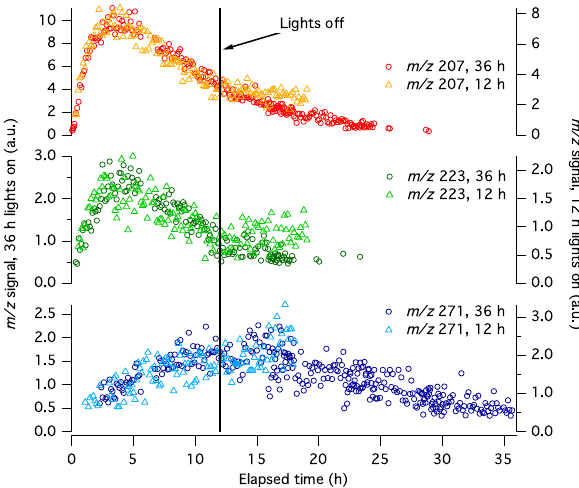
Fig. 11. Time evolution of products formed during m -xylene oxida- tion detected by the CIMS. The signals labeled 36 h were recorded during the set of experiments in which the chamber contents were irradiated for 36 h. The signals labeled 12 h were recorded during the experiment in which the lights were turned off after 12.4 h of irradiation and remained off for the remainder of the experiment.